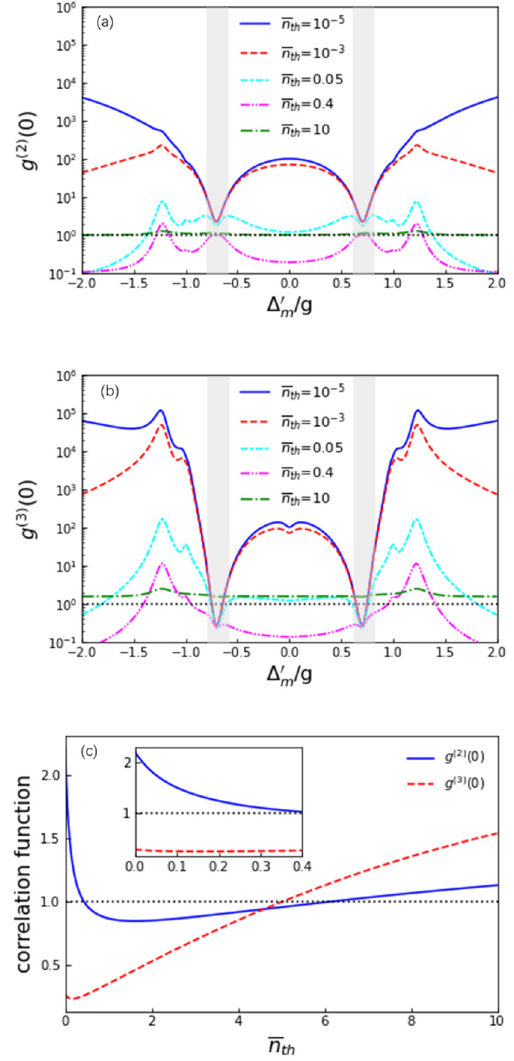
Figure 6. Steady-state equal-time ( a ) second-order correlation function g ( 2 ) ( 0 ) and ( b ) third-order correlation function g ( 3 ) ( 0 ) versus the detuning ∆ (cid:48) m / g for different thermal phonon numbers n th when the optical cavity is weakly driven. ( c ) The second-order correlation function g ( 2 ) ( 0 ) and third-order correlation function g ( 3 ) ( 0 ) versus the thermal phonon number n th in the case of two-phonon resonant driving. The system parameters are γ = 0.01 κ , ε d = 0.15 κ and g = 3 κ